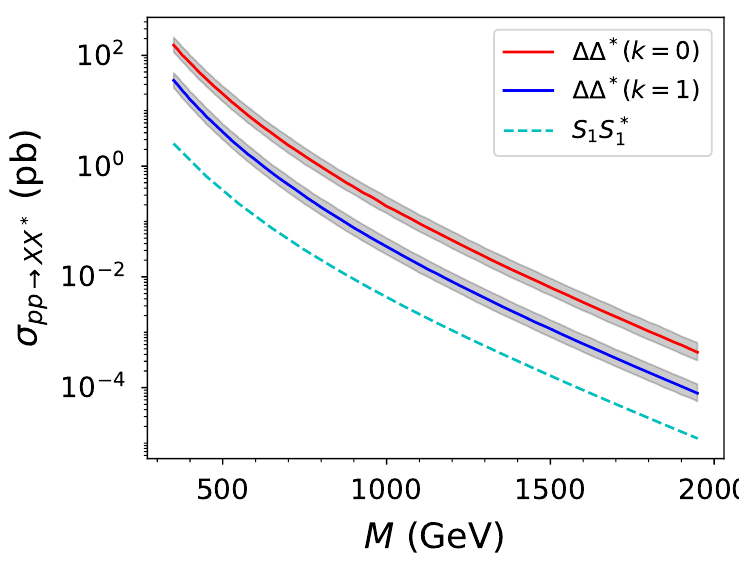
Figure 4 . Pair production cross-section for different LQ models. For the vector LQ ∆ we present results for both the k = 0 and k = 1 scenarios studied in the text. Uncertainties are calculated for the vector leptoquark model by varying the scale in MadGraph5_aMC@NLO 2.8.2 from 0.5 to 2, with respect to the central default value, see main text for details. The scalar model ( S 1 ) is presented as an illustration, being the benchmark model employed in most of the ATLAS and CMS